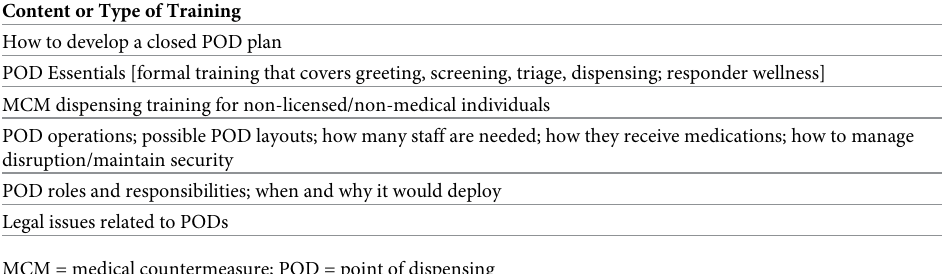
Table 3. Examples of content or types of trainings provided by disaster planners to closed pod site staff. Content or Type of